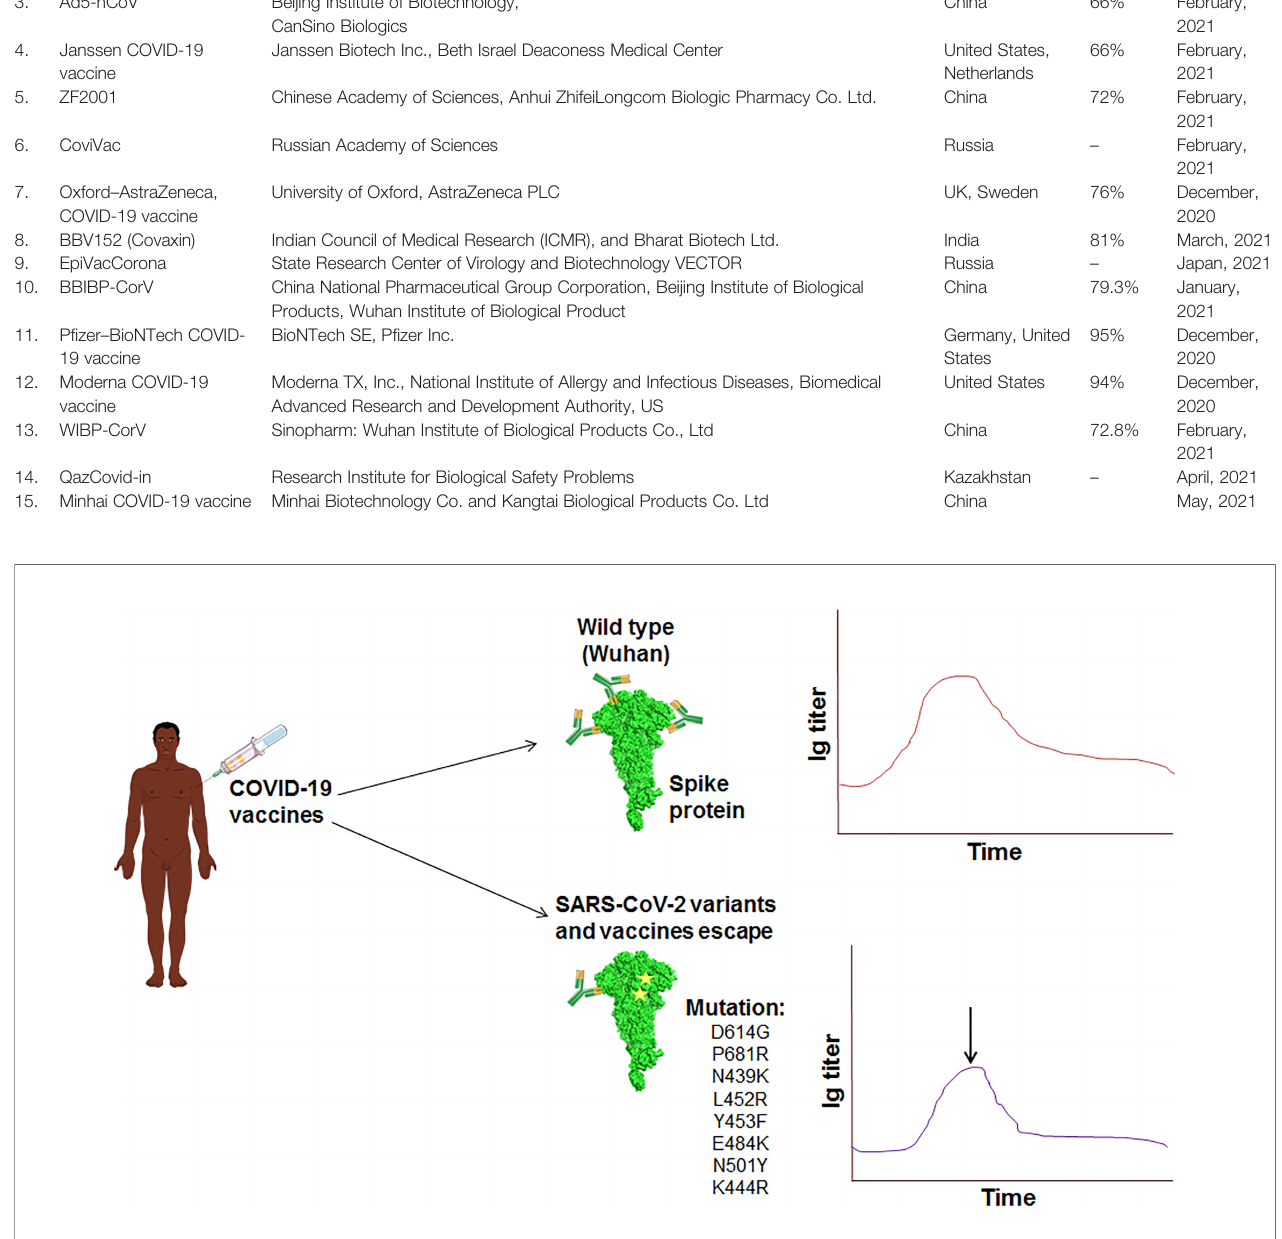
FIGURE 8 | The schematic diagram illustrates the vaccine escape and indicates the vaccine escape